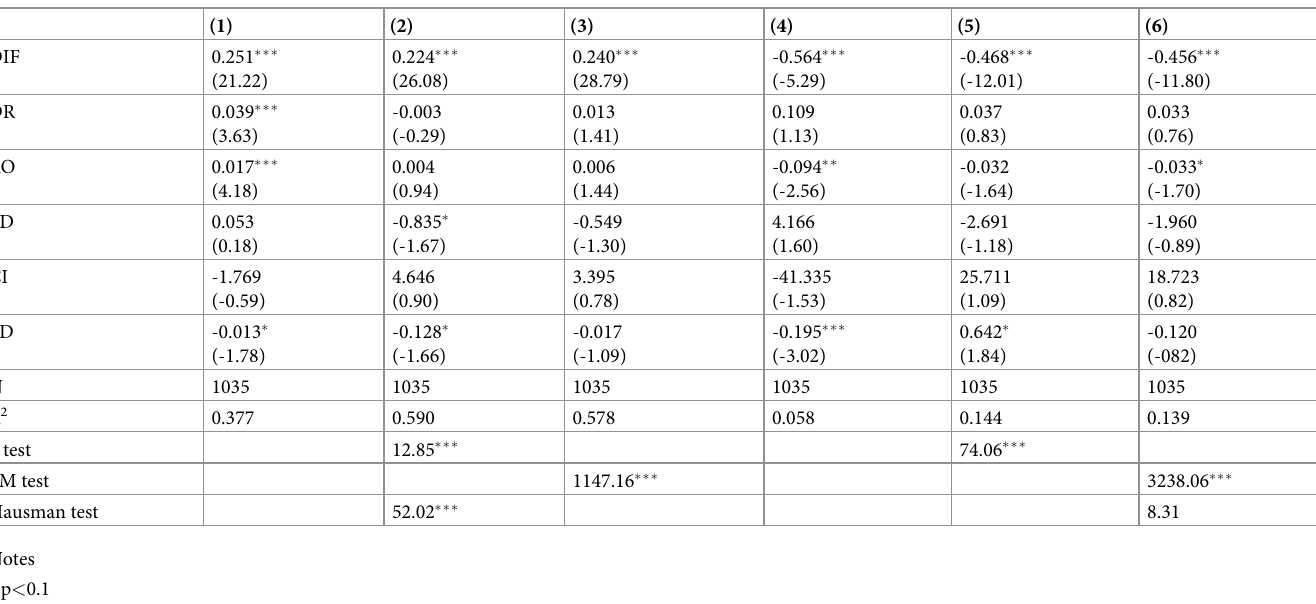
Table 3. Basic regression